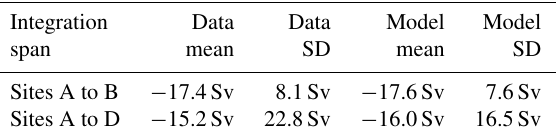
Table 5. Time mean and temporal standard deviation (SD) of the volume transport integrated between 800 and 4800dbar (or the bot- tom where shallower) and between the indicated PIES locations. The observation-based estimates (middle columns) were calculated over the 2009–2014 time period; the model-based estimates (right two columns) were calculated over the 27-year run described in the